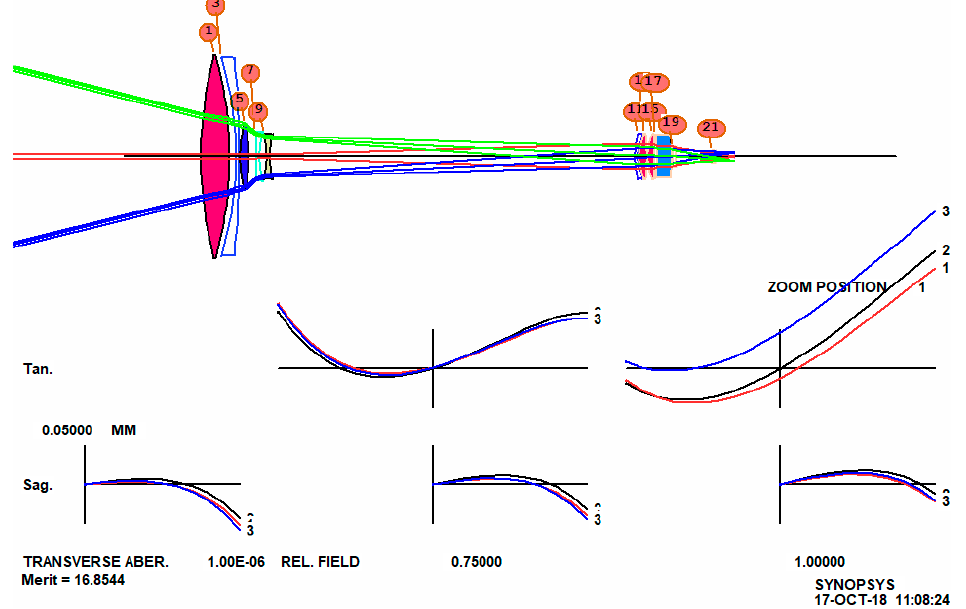
Figure 11. 30X zoom optimized with modified targets. J. Imaging 2018 , 4 , x FOR PEER REVIEW